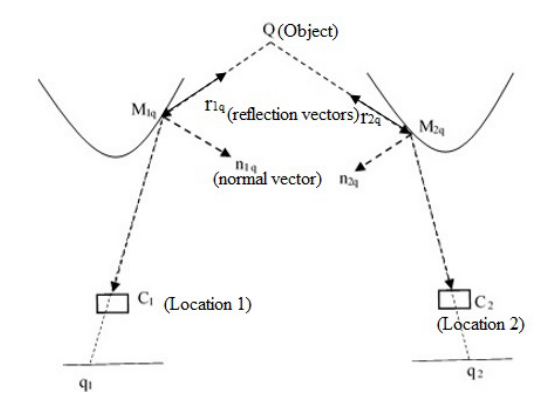
Figure 10: Mapping using 2 positions of the catadioptric sensor The direction of a reflection vectors